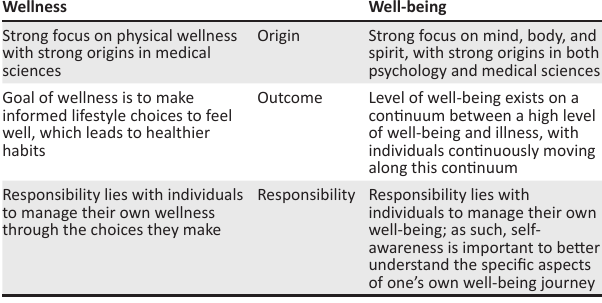
TABLE 1: Wellness and well-being: Similarities and differences.